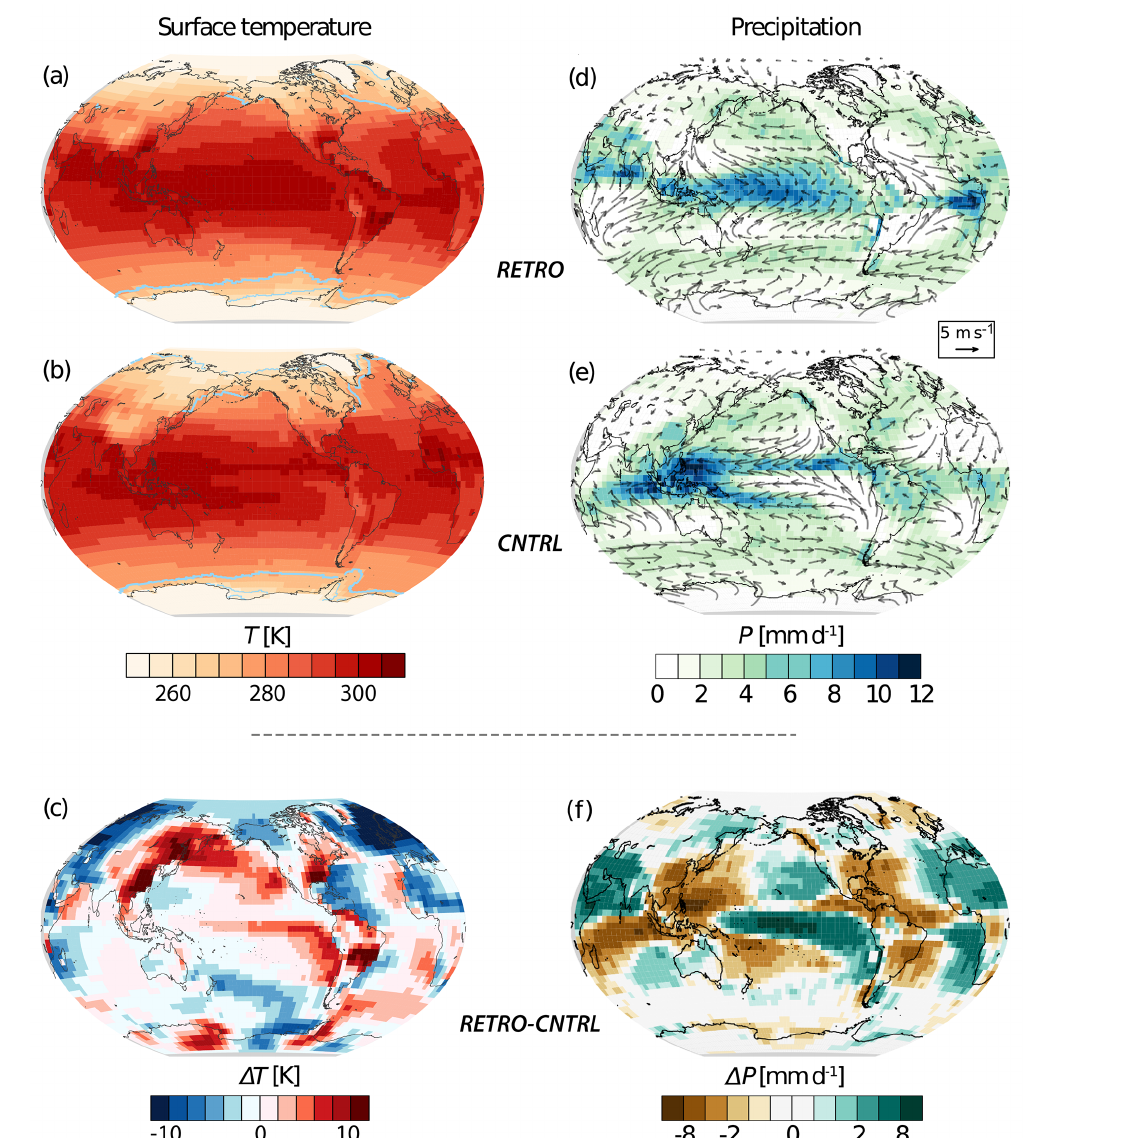
Figure 2. Annual averaged surface temperature in RETRO (a) , CNTRL (b) , and the difference between both simulations (c) . The light blue lines indicate the locations of 1 and 11 months of sea-ice coverage; annual precipitation in RETRO (d) , CNTRL (e) , and the difference between the two simulations (f) . The curly vectors depict the annually averaged 10m wind. The seasonal cycle is shown in videos in https://doi.org/10.5446/36560, https://doi.org/10.5446/36556, https://doi.org/10.5446/36557, https://doi.org/10.5446/36559 and https://doi.